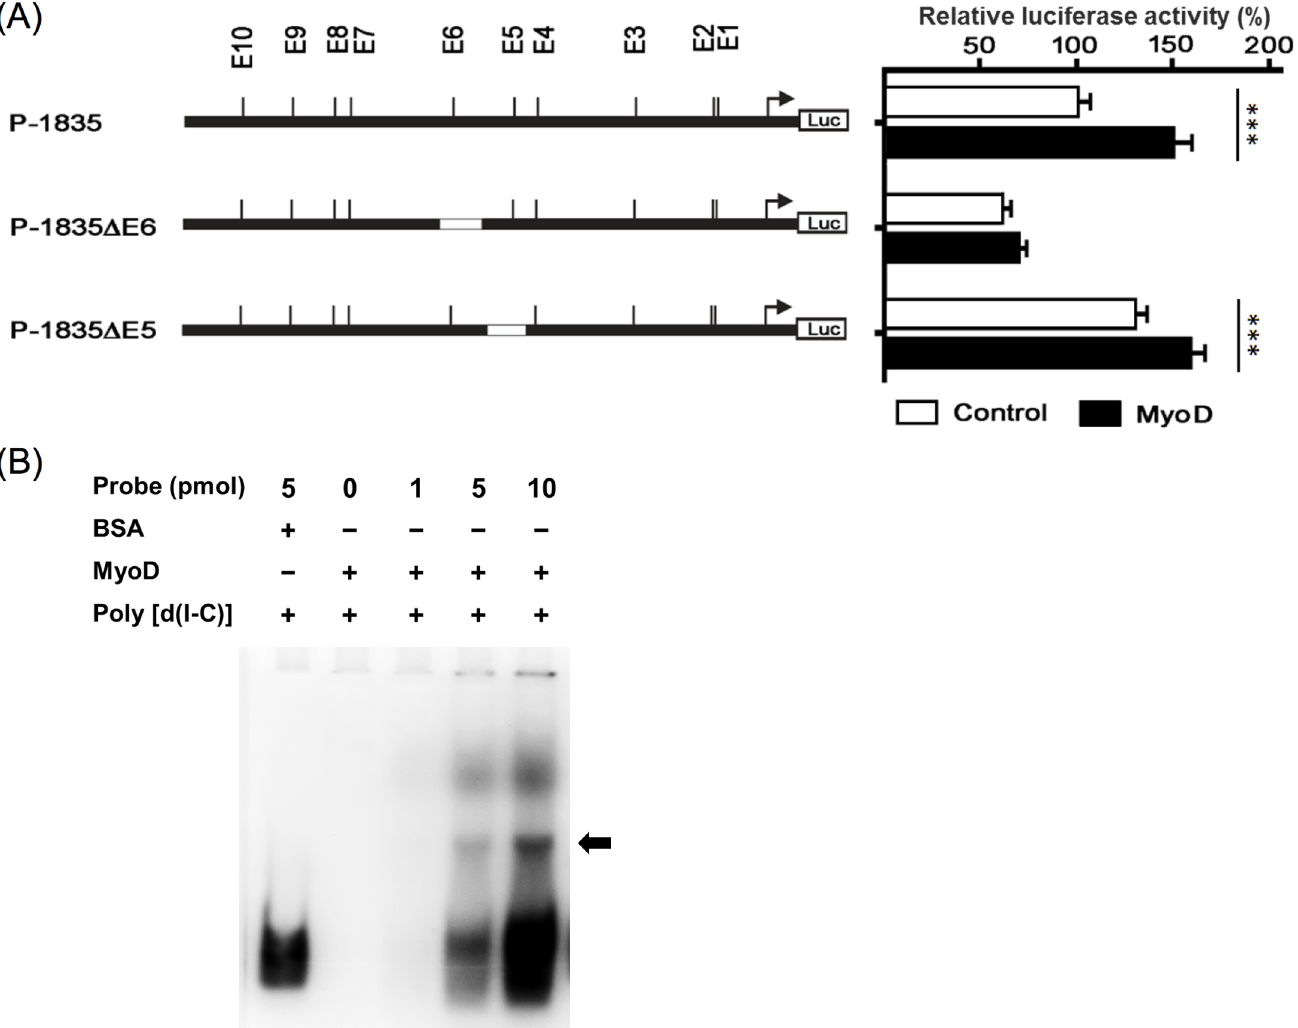
Fig 3. The trans- regulation of MyoD through the E-boxes. (A) Orange-spotted grouperMyoD gene were cloned in the expressionvector pcDNA3.1 and cotransfectedwith the construct containinginternaltruncations of E-box E5 (P-1835 Δ E5) or E6 (P-1835 Δ E6). Bars indicateaverages ± standard deviationsfor three replicates and asterisks show significantdifferences ( *** p < 0.001). (B) The electrophoretic mobility shift assay of E-box E6 and MyoD. Cy3-labeled DNA probeswere incubatedwith BSA or purifiedrecombinant MyoD (2 μ g). The arrow indicatesthe resultingprotein-DNA complexesseparated from free DNA